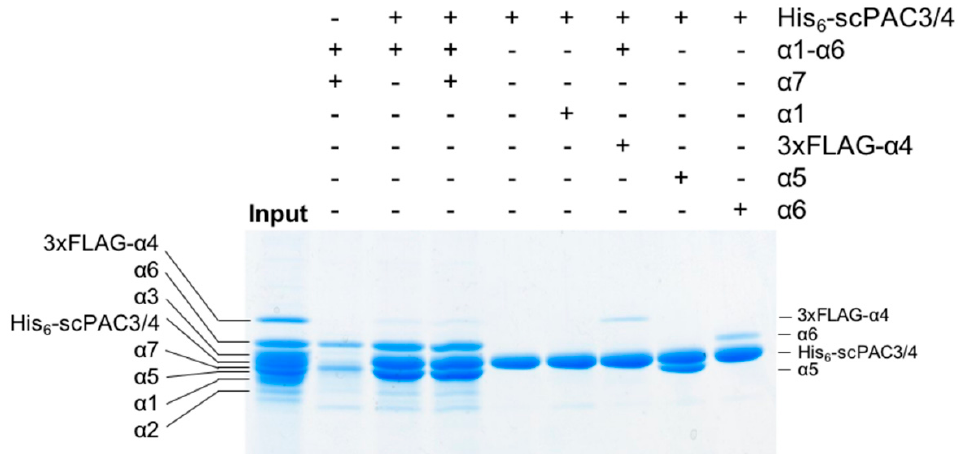
Figure 1. Pull-down experiments between the PAC3-PAC4 heterodimer and proteasome α subunits. The non-tagged α 1– α 3 and α 5– α 7 along with 3xFLAG-tagged α 4 were mixed with His 6 -tagged scPAC3 / 4 immobilized on Ni 2 + -charged Chelating Sepharose beads. The 3xFLAG-tagged α 4 was used to avoid the band overlap between α 4 and scPAC3 / 4. After extensive washing, bound proteins were analyzed using CBB staining after sodium dodecyl sulfate polyacrylamide gel electrophoresis (SDS-PAGE). The ‘Input’ lane contained all α subunits and His 6 -scPAC3 / 4 (0.5 µ g each). The SDS-PAGE bands were assigned according to Figure S1a, and the bands originating from the His 6 -scPAC3 / 4 and the bound α subunits are labeled.